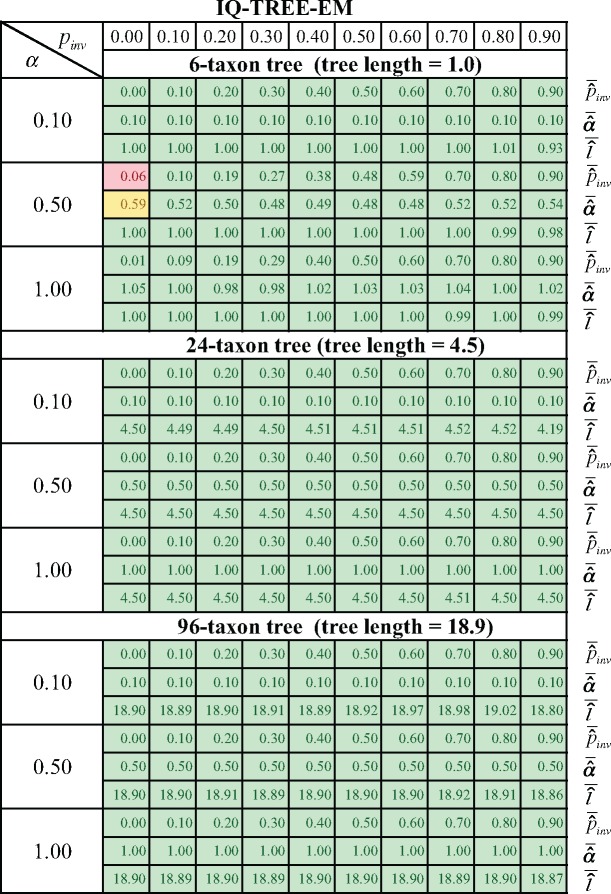
The averages \documentclass[12pt]{minimal}
\usepackage{amsmath}
\usepackage{wasysym} 
\usepackage{amsfonts} 
\usepackage{amssymb} 
\usepackage{amsbsy}
\usepackage{upgreek}
\usepackage{mathrsfs}
\setlength{\oddsidemargin}{-69pt}
\begin{document}
}{}$\bar{\hat{\alpha }}$\end{document} of the estimated shape parameter \documentclass[12pt]{minimal}
\usepackage{amsmath}
\usepackage{wasysym} 
\usepackage{amsfonts} 
\usepackage{amssymb} 
\usepackage{amsbsy}
\usepackage{upgreek}
\usepackage{mathrsfs}
\setlength{\oddsidemargin}{-69pt}
\begin{document}
}{}$\alpha $\end{document}, the averages \documentclass[12pt]{minimal}
\usepackage{amsmath}
\usepackage{wasysym} 
\usepackage{amsfonts} 
\usepackage{amssymb} 
\usepackage{amsbsy}
\usepackage{upgreek}
\usepackage{mathrsfs}
\setlength{\oddsidemargin}{-69pt}
\begin{document}
}{}$\overline{\widehat{p_{inv}}}$\end{document} of the estimated invariable fraction \documentclass[12pt]{minimal}
\usepackage{amsmath}
\usepackage{wasysym} 
\usepackage{amsfonts} 
\usepackage{amssymb} 
\usepackage{amsbsy}
\usepackage{upgreek}
\usepackage{mathrsfs}
\setlength{\oddsidemargin}{-69pt}
\begin{document}
}{}$p_{\rm inv}$\end{document} and the average \documentclass[12pt]{minimal}
\usepackage{amsmath}
\usepackage{wasysym} 
\usepackage{amsfonts} 
\usepackage{amssymb} 
\usepackage{amsbsy}
\usepackage{upgreek}
\usepackage{mathrsfs}
\setlength{\oddsidemargin}{-69pt}
\begin{document}
}{}$\bar{\hat{l}}$\end{document} of the estimated tree length \documentclass[12pt]{minimal}
\usepackage{amsmath}
\usepackage{wasysym} 
\usepackage{amsfonts} 
\usepackage{amssymb} 
\usepackage{amsbsy}
\usepackage{upgreek}
\usepackage{mathrsfs}
\setlength{\oddsidemargin}{-69pt}
\begin{document}
}{}$l$\end{document} produced by IQ-TREE-EM for the 100 alignments simulated from each parameter combinations. The highlighting is explained in Fig. 1.